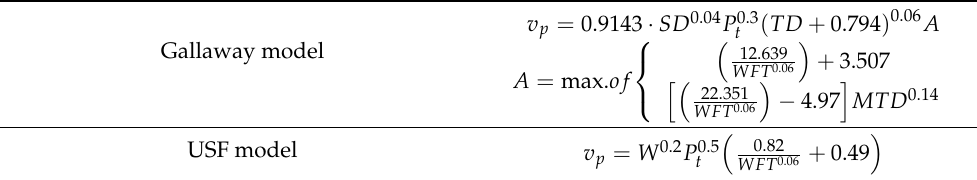
Table 4. Gallaway model and USF model.